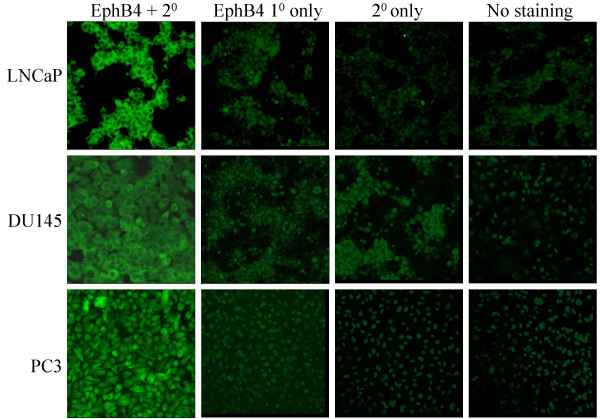
Immunofluorescent staining of EphB4 in prostate cancer cell lines. Immunofluorescent staining of EphB4 in prostate cancer cell lines showing diffuse staining on the surface and in the cytoplasm of LNCaP and DU145 and in the cytoplasm only of PC3. There was no reactivity to the primary antibody (EphB4 1° only) or secondary antibody (2° only) alone and little background fluorescence (No staining).